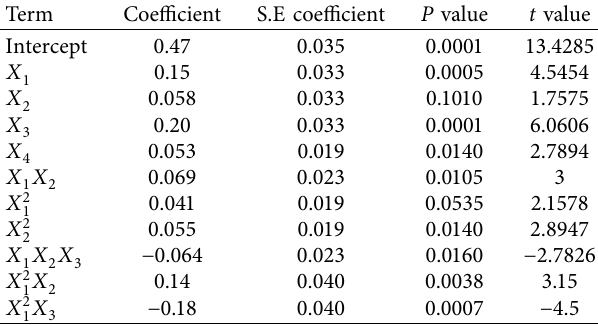
Table 6: Estimated effects and coefficients for the total ores